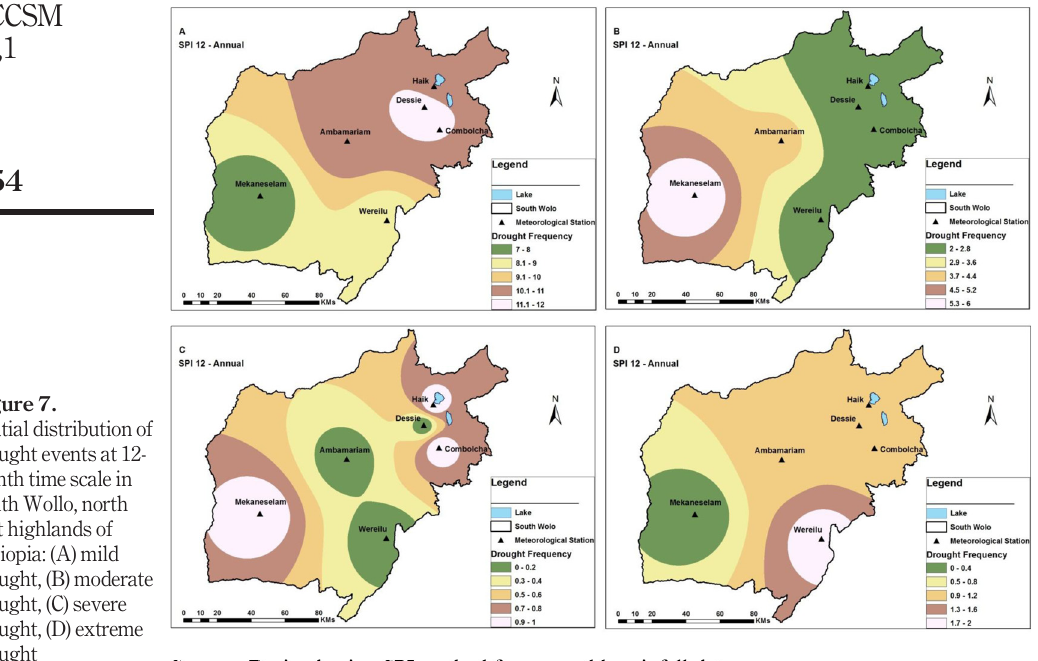
Figure 7. Spatial distribution